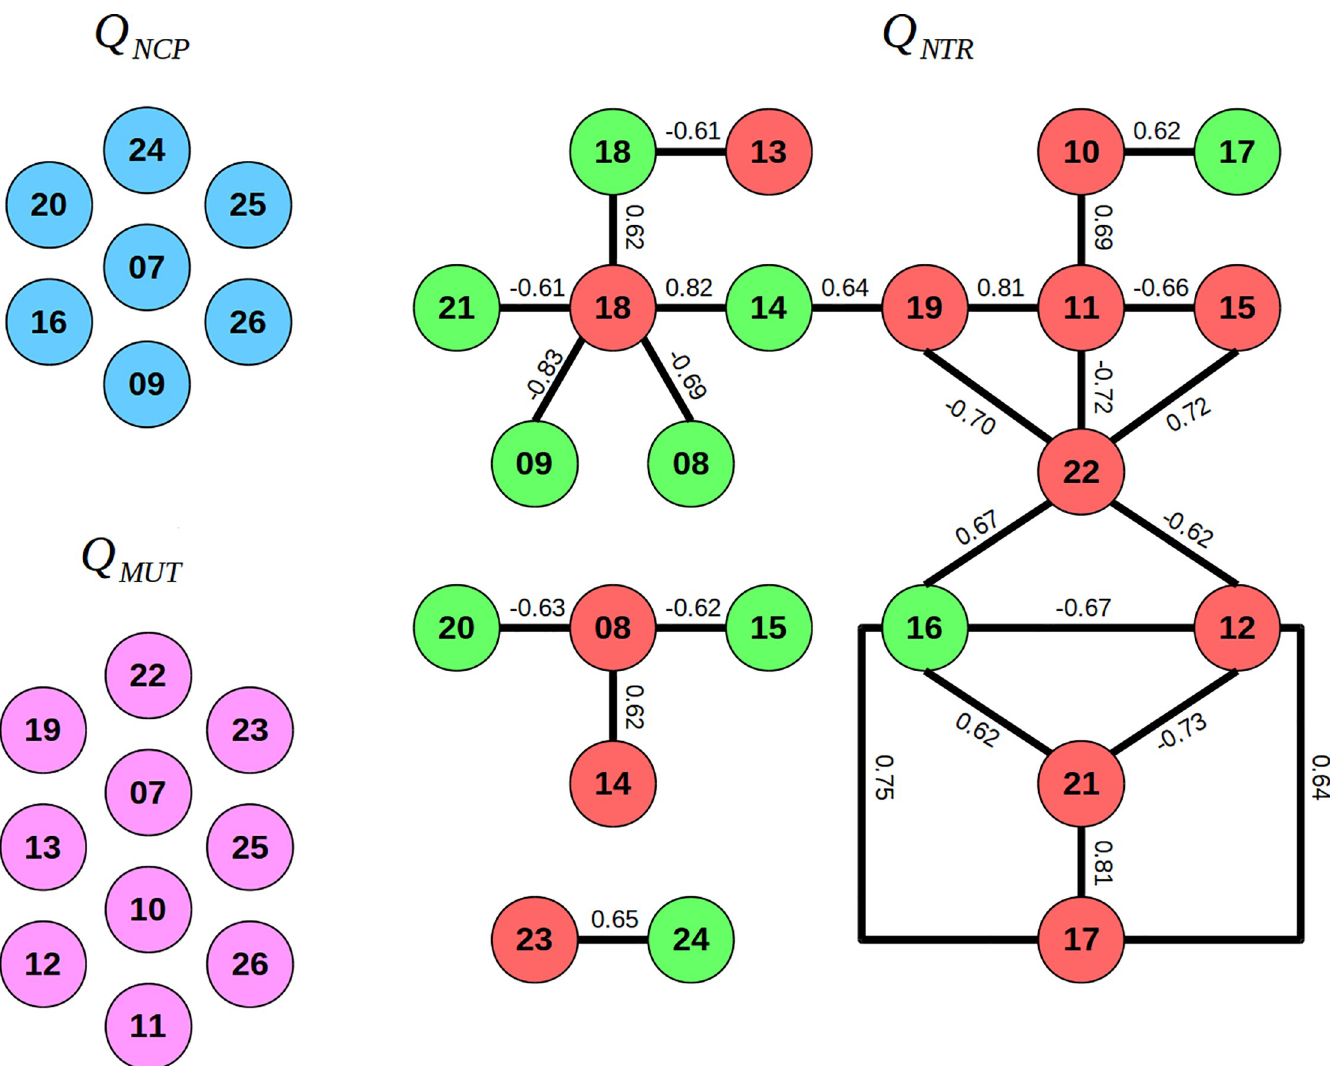
Fig 5. Motion redundancy among the 20 lowest frequency normal modes computed for TrkA complexed with wild type and mutant NGF. The mantel similarity scores revealed that a number of WT and R221W normal modes (red and green nodes, respectively) preserve a given motion. Thus, since both WT and mutant NGF are capable to induce neurotrophic response, these similar modes are putatively assigned to activate the neurotrophic bias of TrkA. On the other hand, independent WT motions (blue nodes), that have no similarity either with all other WT motions or R221W ones, are hypothesized as responsible to nociceptive bias of TrkA, since they are present only in WT structures. Also, independent R221W motions (magenta nodes) may introduce an impairment in communication pathways. Numbers in circles are non-trivial NM numbers of respective systems. Values on edges correspond to the Mantel similarity scores between the connected modes; only pairs of modes with similarity score greater than |0.6| were connected in these graphs. Note that the modes considered start with the number 7, since the modes from 1 to 6 correspond to trivial overall translation/rotation of the